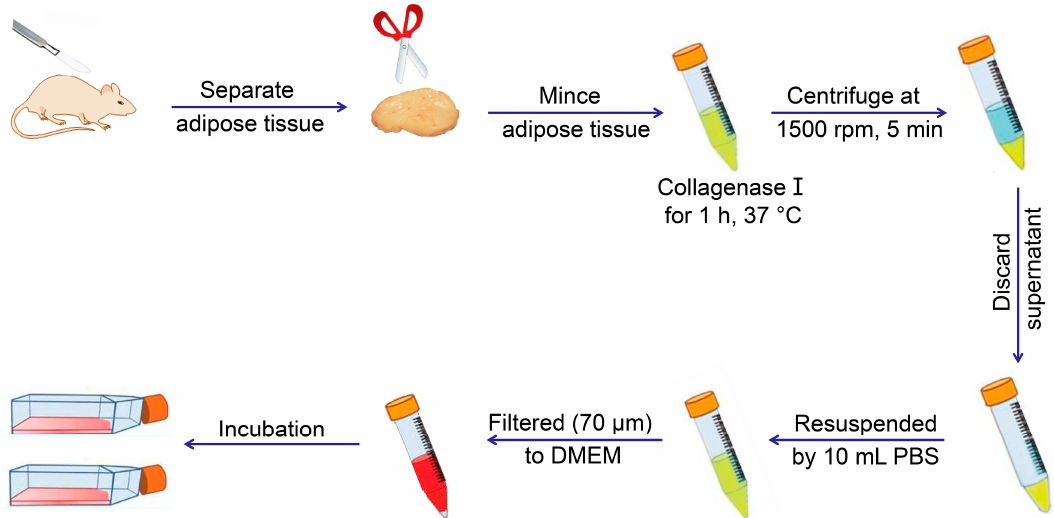
Figure 2. Typical extraction process of adipose-derived mesenchymal stem cells from adipose tissue of mouse. of